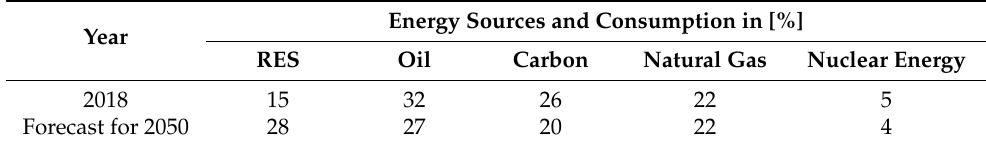
Table 2. World consumption of electricity from various sources [%]—comparison of 2018 to the forecasts for 2050—own study based on data